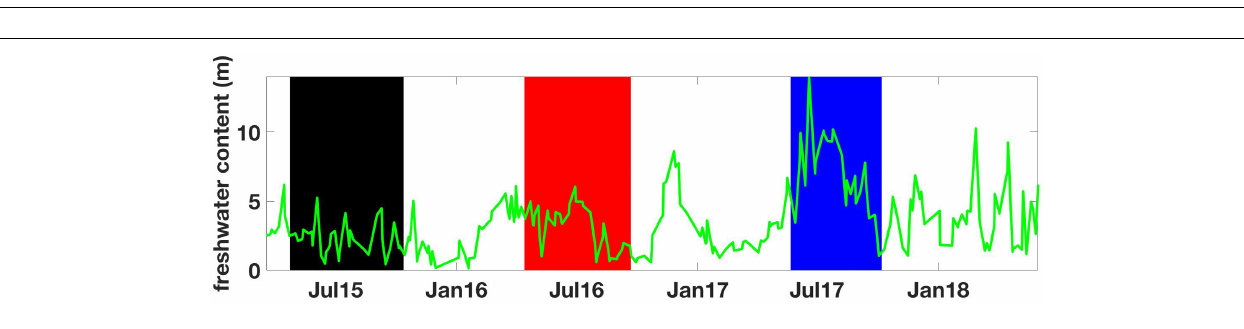
FIGURE 8 | Freshwater content at QU39 from March 18, 2015 to June 1, 2018 computed using a reference salinity of 29.1 following the relationship from Proshutinsky et al. (2009). Vertical shaded areas mark the time periods between spring and fall transitions color-coded to match the years shown in Supplementary Figures S5 , S6